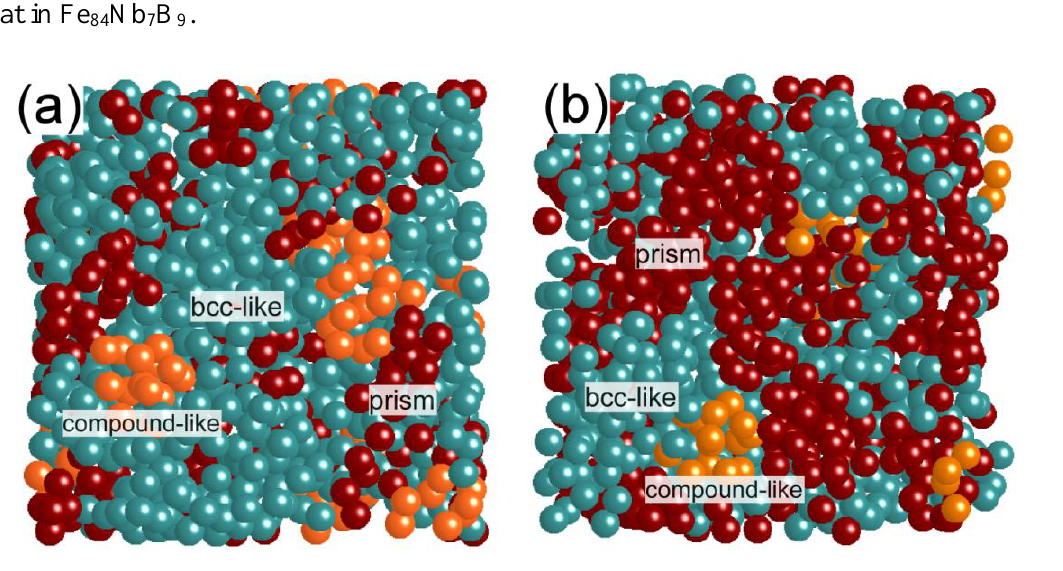
Nb B metallic glasses obtained 70 10 20 Nb B is smaller than 70 10 20